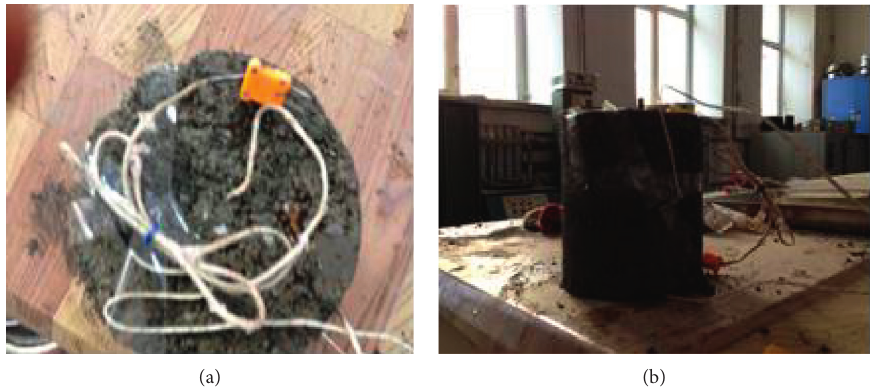
Figure 6: Sensors embedded in specimen. (a) Central sensors. (b) Middle external